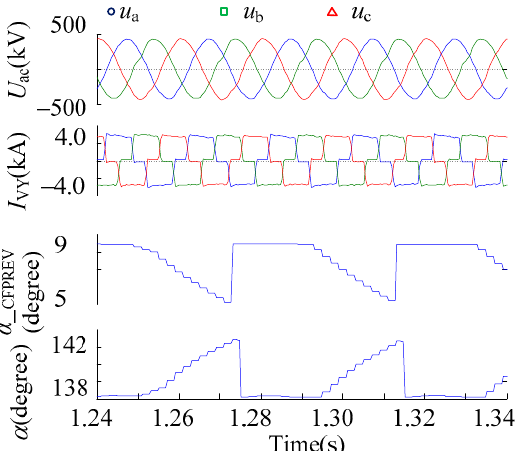
Figure 3. The performance of the commutation failure prediction during the disturbance. (Note: U ac is